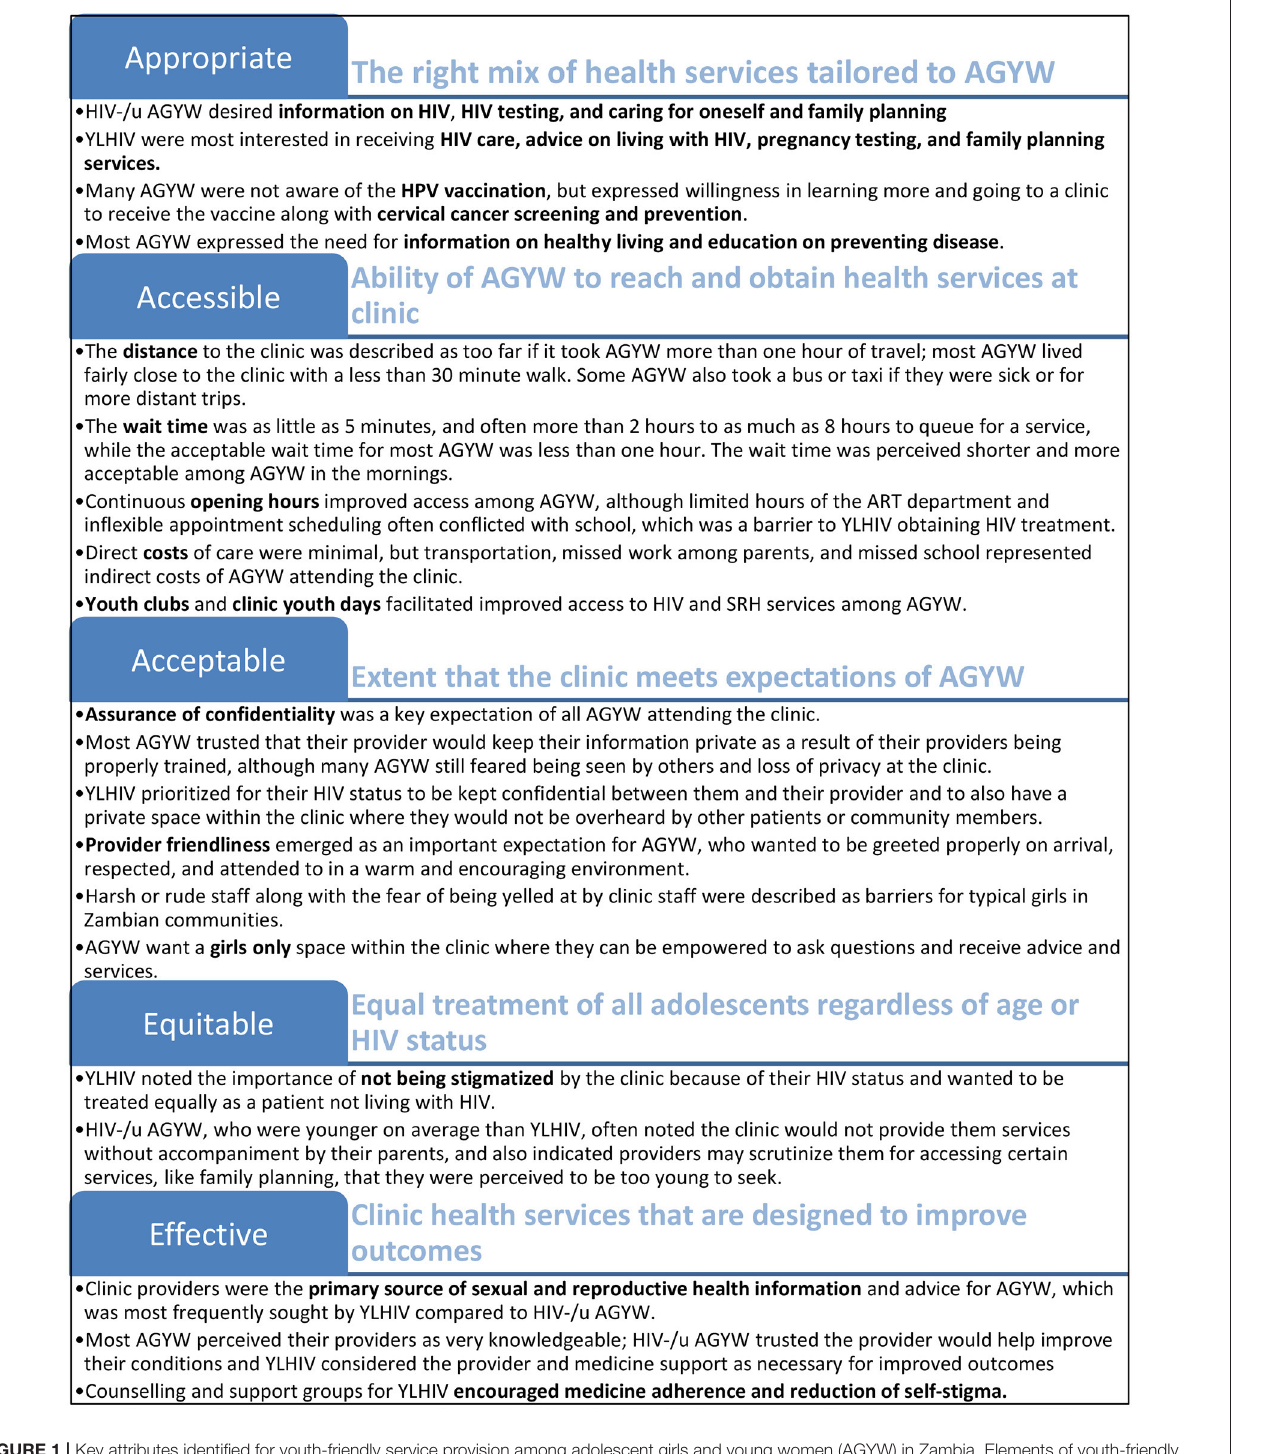
FIGURE 1 | Key attributes identified for youth-friendly service provision among adolescent girls and young women (AGYW) in Zambia. Elements of youth-friendly service provision are based on World Health Organization quality of care framework. AGYW, adolescent girls and young women; ART, anti-retroviral treatment; HIV-/u AGYW, adolescent girls and young women who were HIV-negative or of unknown status; YLHIV, adolescent girls and young women who are living with HIV. Bullets that describe AGYW are findings reflected across both HIV-/u AGYW and YLHIV.